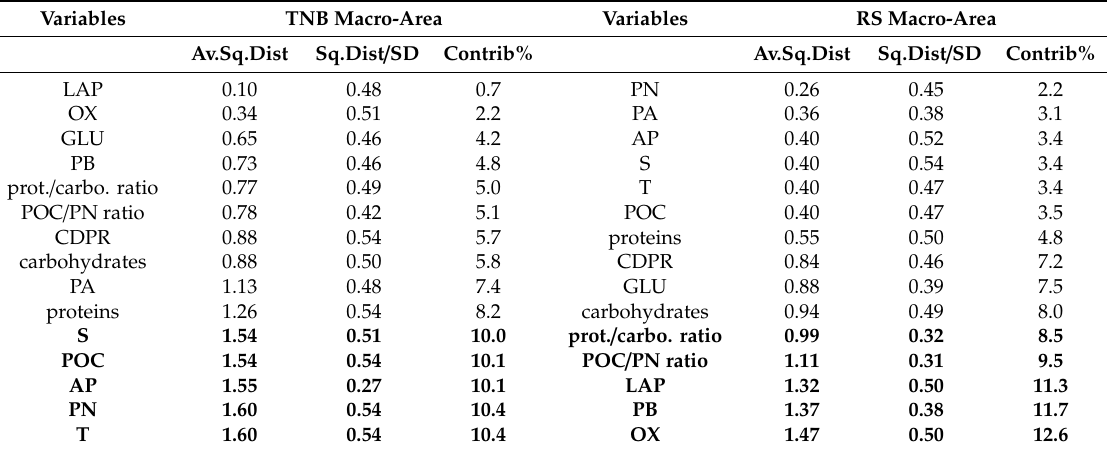
Table 3. SIMPER analysis results: main factors contributing to the grouping of the observations within the two macro-areas. (In bold the most relevant variables a ff ecting the dissimilarity) Variables TNB Macro-Area Variables RS